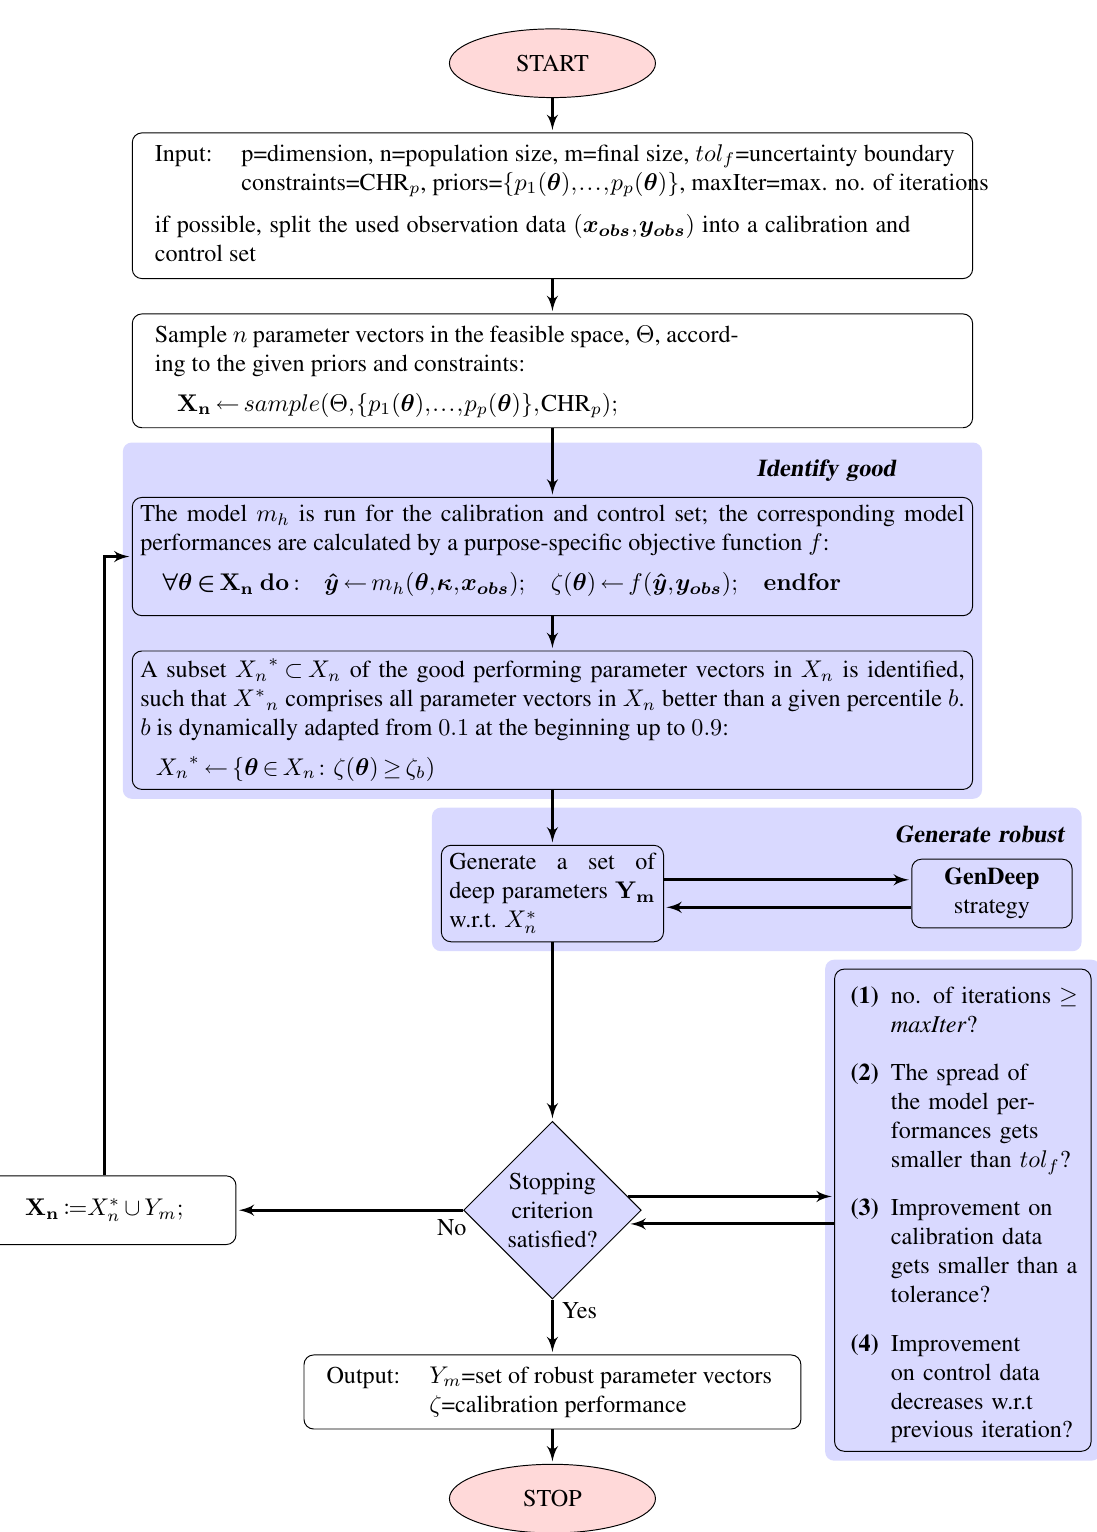
Fig. 5. Flowchart of the Advanced Robust Parameter Estimation by Monte Carlo Simulation (A-ROPE) algorithm.